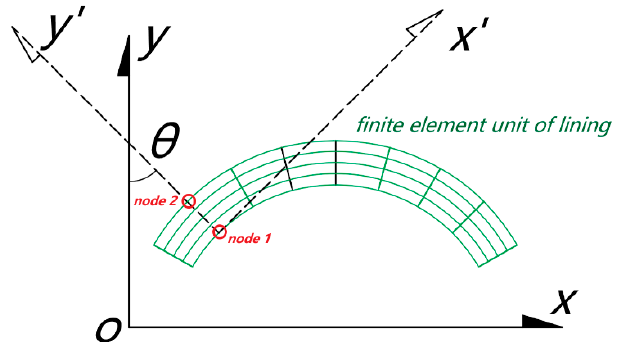
Figure 16. Coordinate transformation for node stress of lining unit.